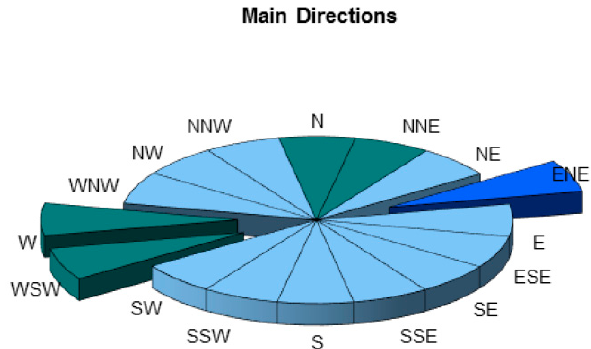
Figure 6. Wind Rose main results regarding the main wind directions for the Um Al Rumman meteorological mast .